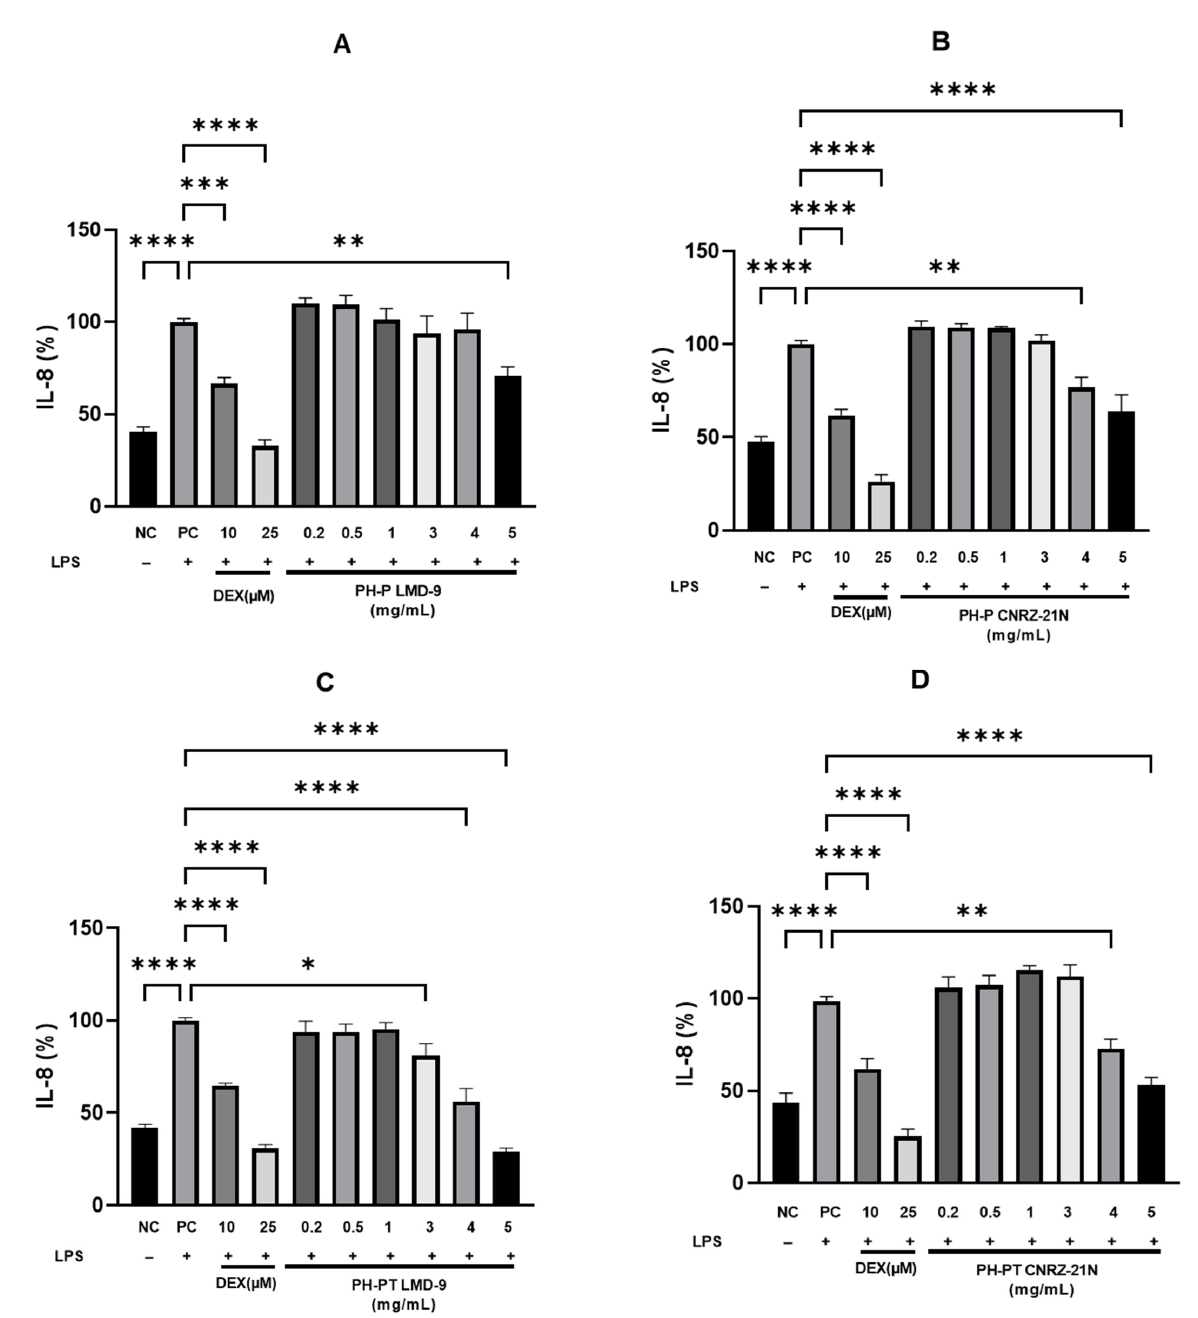
Figure 3. Anti-inflammatory activity highlighted in vitro of hydrolysates recovered after peptic shaving (PH-P) or peptic shaving followed by trypsinolysis (PH-PT) of S. thermophilus LMD-9 or CNRZ-21N. The effect of PH-P of LMD-9 ( A ), CNRZ-21N ( B ), and of PH-PT of LMD-9 ( C ), CNRZ-21N ( D ) on the IL-8 secretion in LPS-induced HT-29 cells. Three hour co-incubation of HT-29 cells was performed either with LPS (50 ng/mL) alone or with LPS and PH-P (0.2–5 mg/mL) or LPS and PH-PT (0.2–5 mg/mL) or LPS and dexamethasone (DEX, 10 or 25 µM). After 3 h, IL-8 secretion levels in the cell culture medium were determined by ELISA. The negative control (NC) represents the incubation of untreated cells. IL-8 (%) is the percentage of IL-8 released by cells relative to its secretion by cells treated only by LPS (PC). All data are represented as the means ± SEM of three experiments performed independently (N = 3). * p < 0.05, ** p < 0.01, *** p < 0.001, **** p <